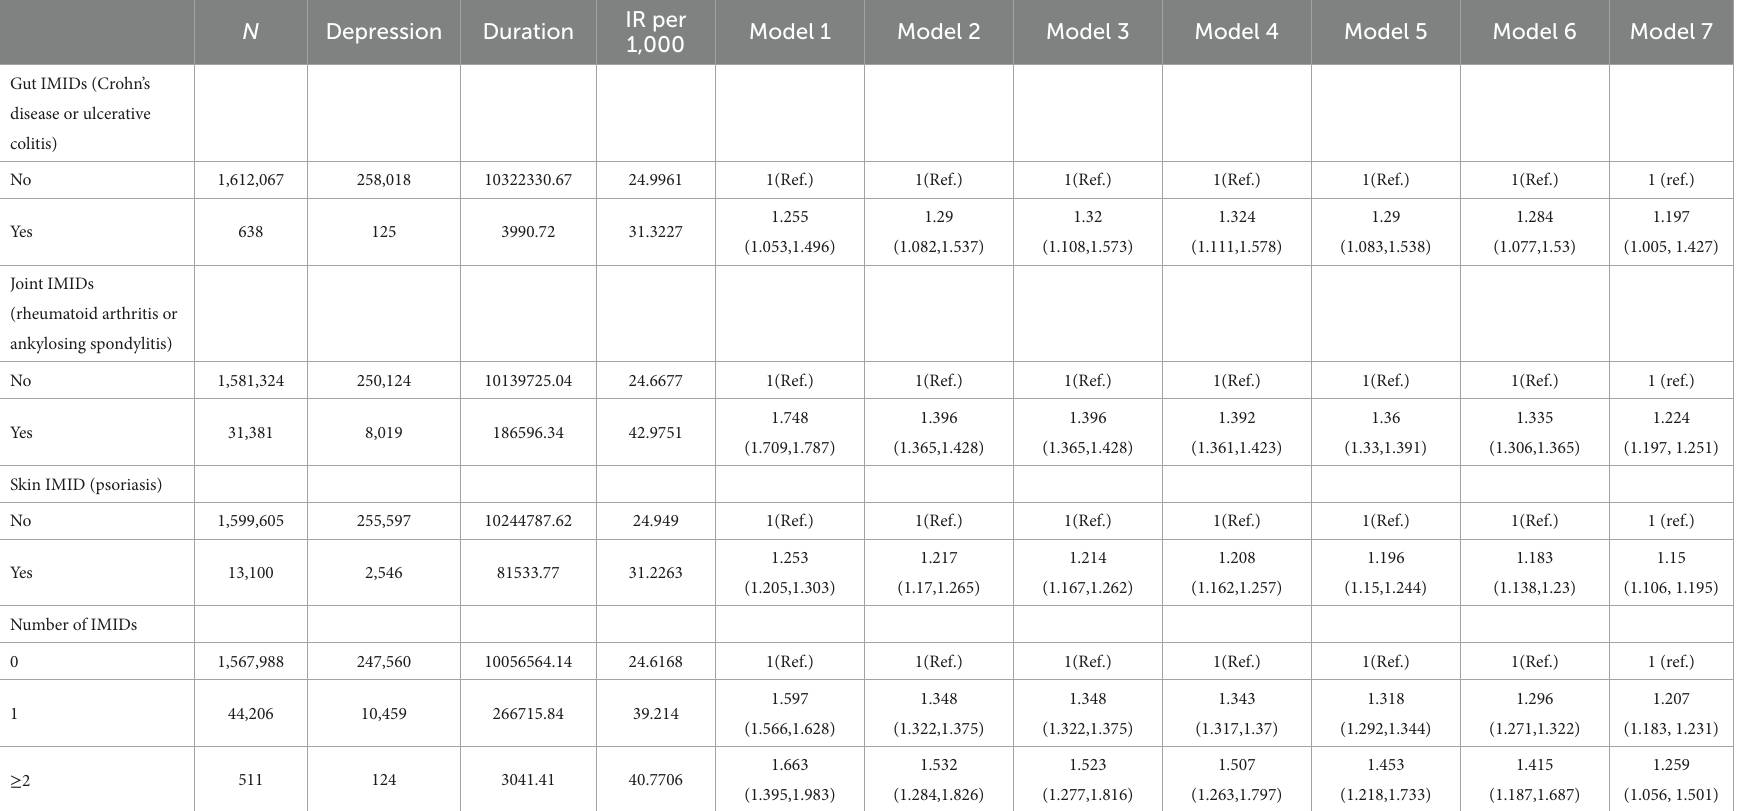
TABLE 2 Risk of depression according to the presence of immune-mediated inflammatory